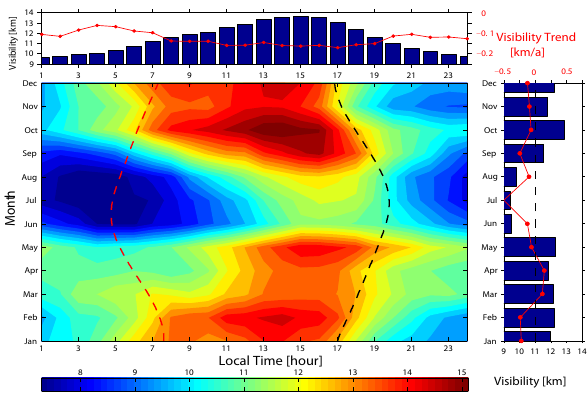
Fig. 3. Visibility distribution in relation to Month and Local Time (filled color). The blue bars at the top (on the right) denote mean visibility over the entire period 1999 to 2007 for each hour (month). The red curves denote visibility trend in BCIA from 1999 to 2007. Red dash line represents sunrise time and black dash line represents sunset time.